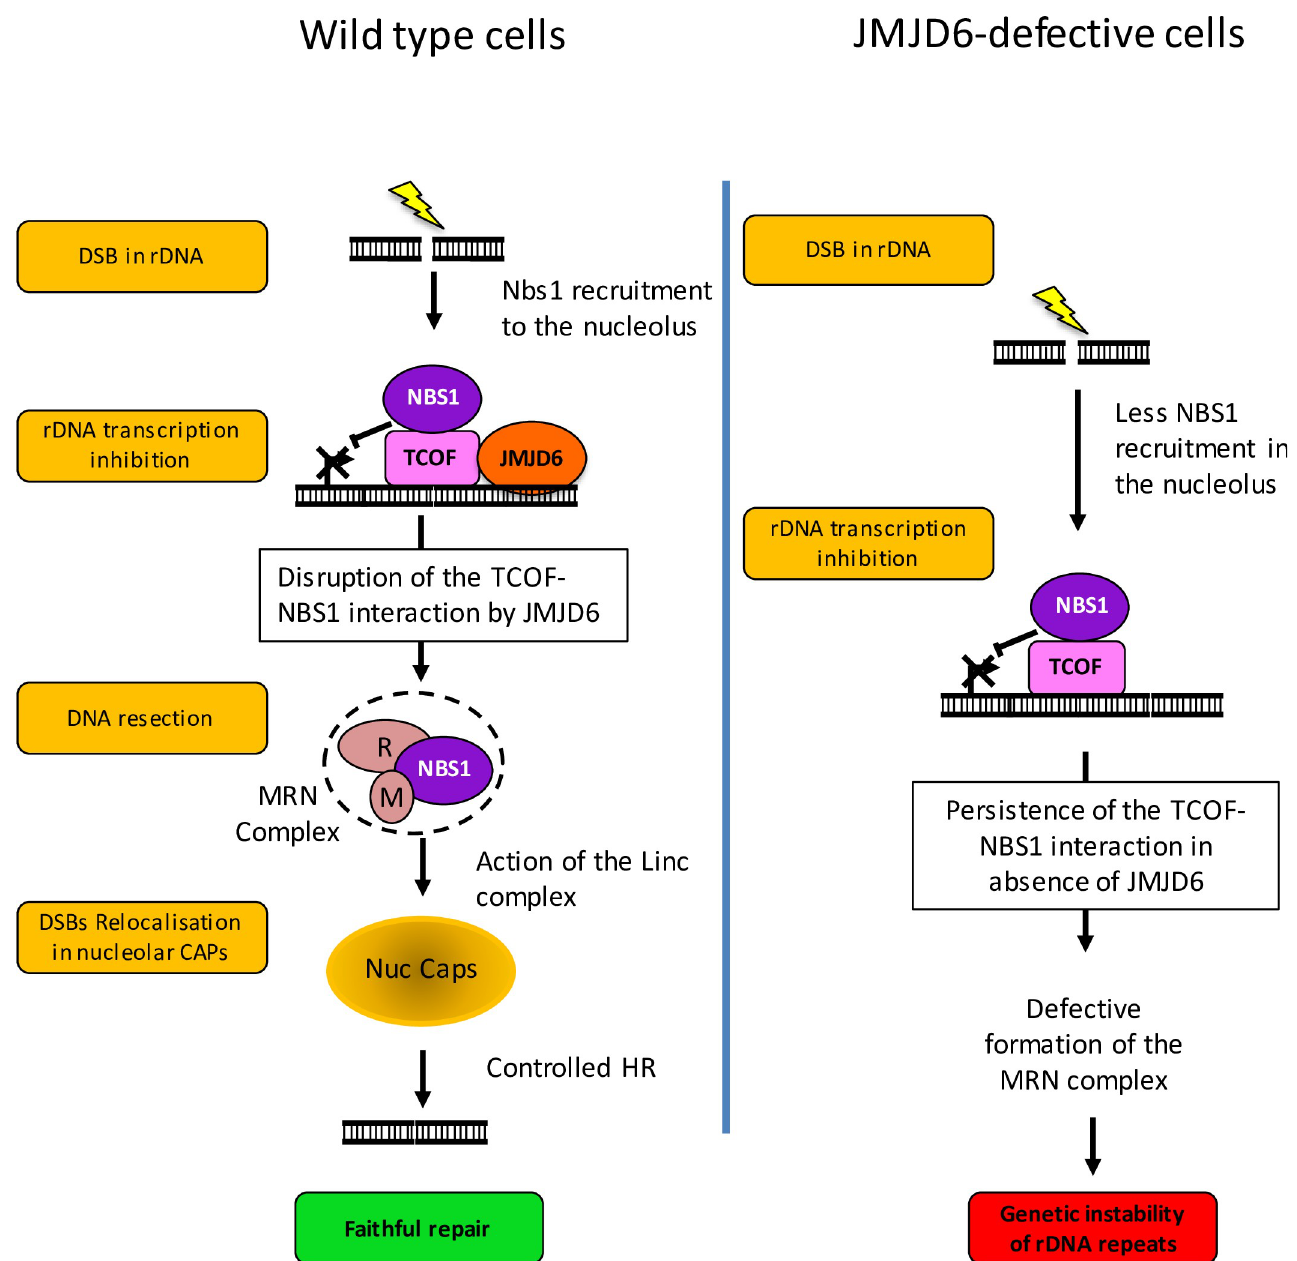
Fig 11. Working model on the role of JMJD6 in rDNA breaks management. Upon induction of rDNA breaks in wild type cells (left), JMJD6 in association with TCOF1 restricts the NBS1-TCOF1 interaction, allowing NBS1 to be available to initiate resection within the MRN complex and therefore leading to nucleolar caps formation and faithful homologous recombination. In JMJD6-depleted cells (right), the NBS1/TCOF1 complex still forms, allowing transcriptional repression, but nucleolar caps formation is defective, resulting in a genetic instability of rDNA arrays.